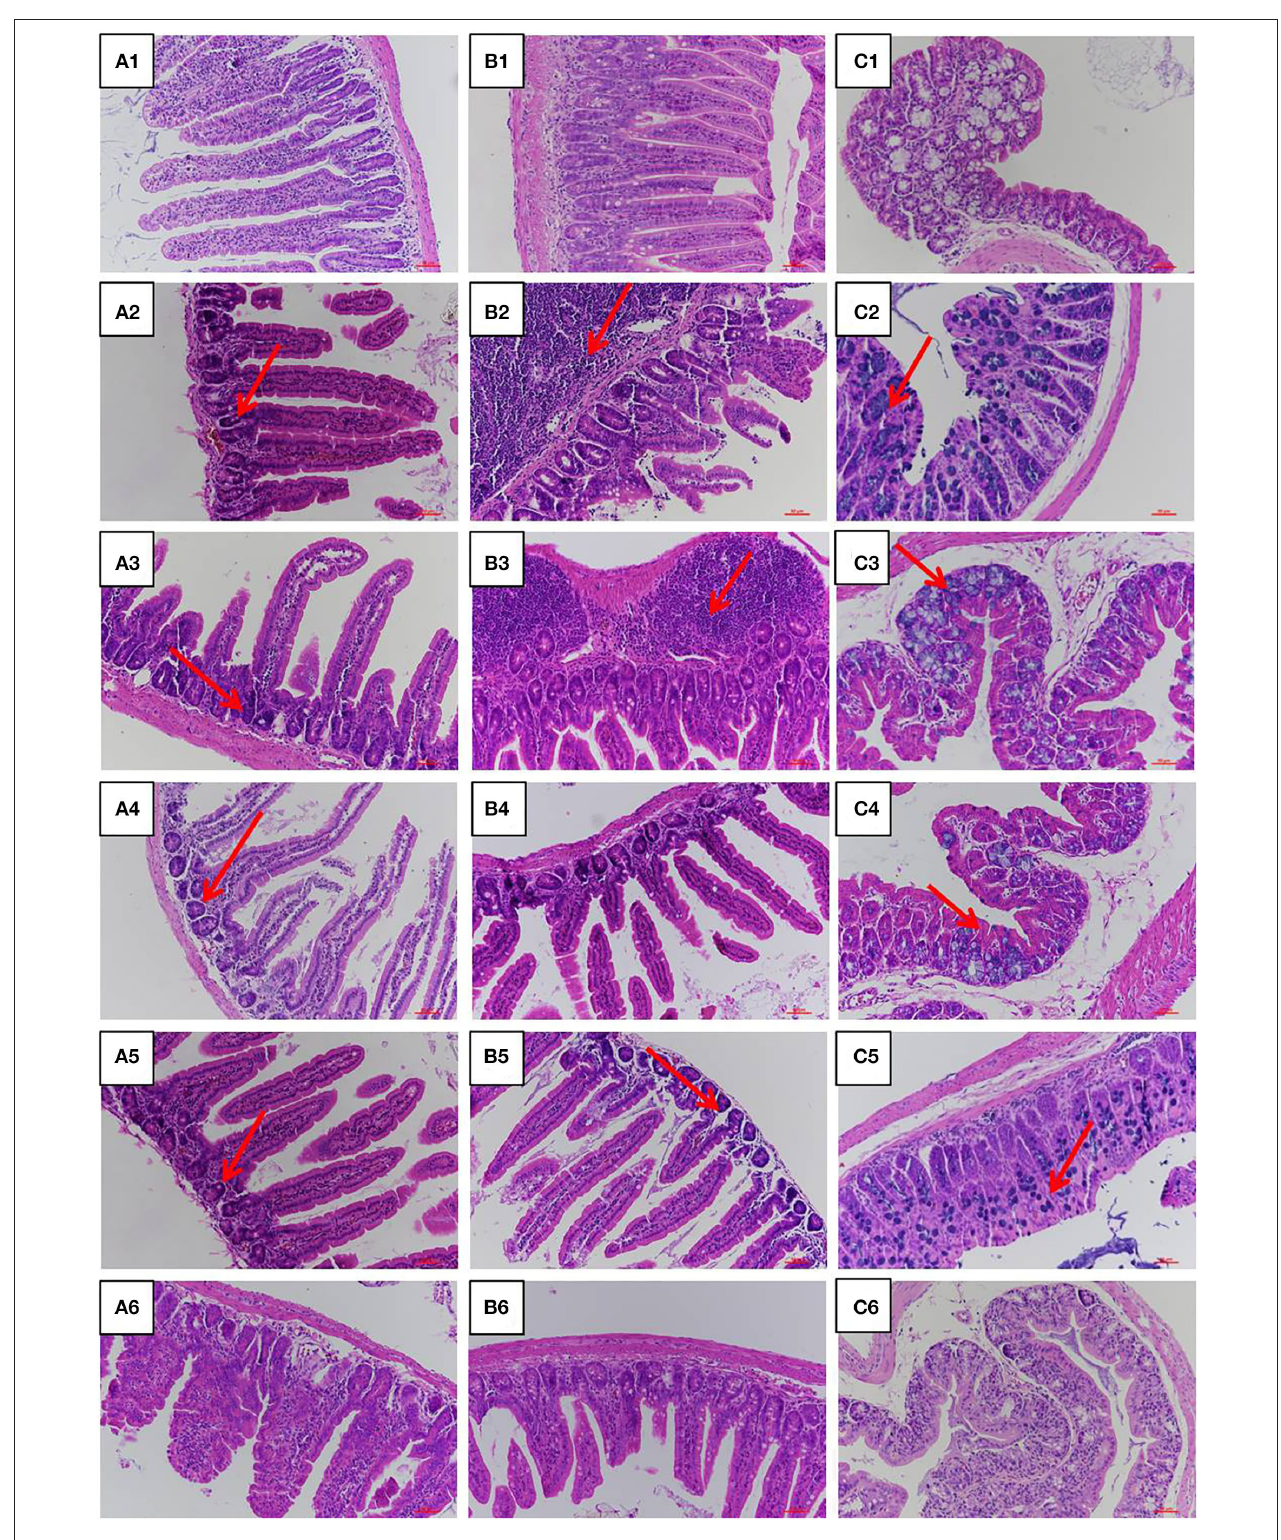
FIGURE 3 | Jejunum (A) , ileum (B) , and colon (C) intestinal morphology of CON group (1), LPS group (2), LFVP group (3), HFVP group (4), LFFVP group (5), HFFVP group (6). The magnification is 20 × . FV, Flammulina velutipes ; FVP, Flammulina velutipes polysaccharides; CON, control group; LPS, lipopolysaccharide; LFVP, low dose FVP group; HFVP, high dose FVP group; LFFVP, low dose FFVP group; HFFVP, high dose FFVP group.